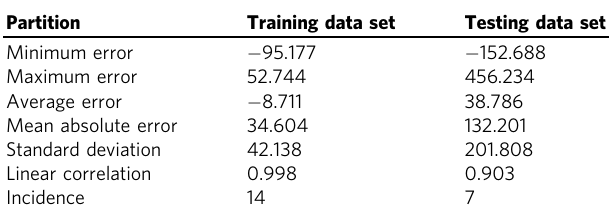
Table 6 Target variable analysis of the arti fi cial neural network prediction model for the in fl uencing factors of construction enterprises ’ adoption of green development behaviors.